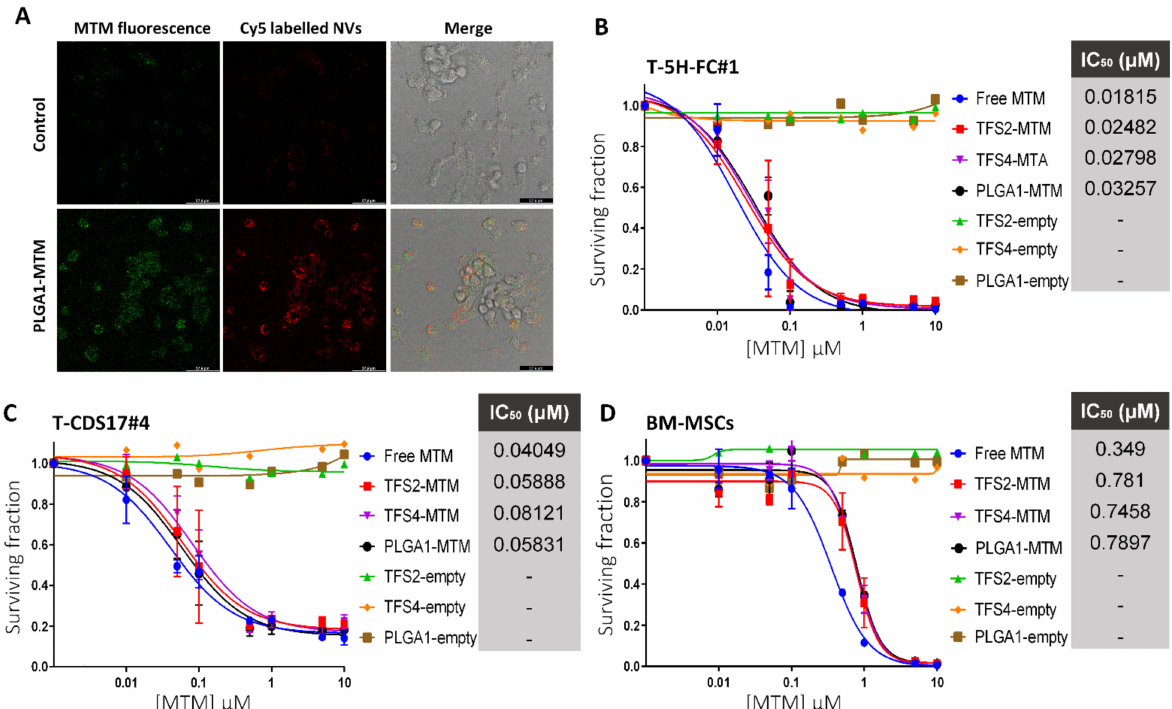
Figure 2. Anti-proliferative effect of the free MTM and nano-encapsulated MTM in sarcoma cells and hBM-MSCs: ( A ) confocal microscopy detection of fluorescence emitted by MTM (green fluorescence; left panels) and Cy5 (red fluorescence; middle panels) in T-5H-FC#1 cells treated with DMSO (control) or 1 µ M MTM loaded in Cy5-labelled NVs-C for 2 h. Bright field images merged with green and red fluorescence emissions are also shown (right panels). Bar scale = 57.9 µ m. (B–D) Cell viability (WST1 assay) measured after the treatment of the mixoid liposarcoma model T-5H-FC#1 ( B ); the patient-derived chondrosarcoma cell line T-CDS17#4; ( C ) or a culture of non-transformed hBM-MSCs ( D ) with increasing concentrations of MTM for 72 h. The effect of equivalent amounts of empty nanoparticles are shown. IC50 values for each treatment are indicated. Error bars represent the standard deviation of three independent